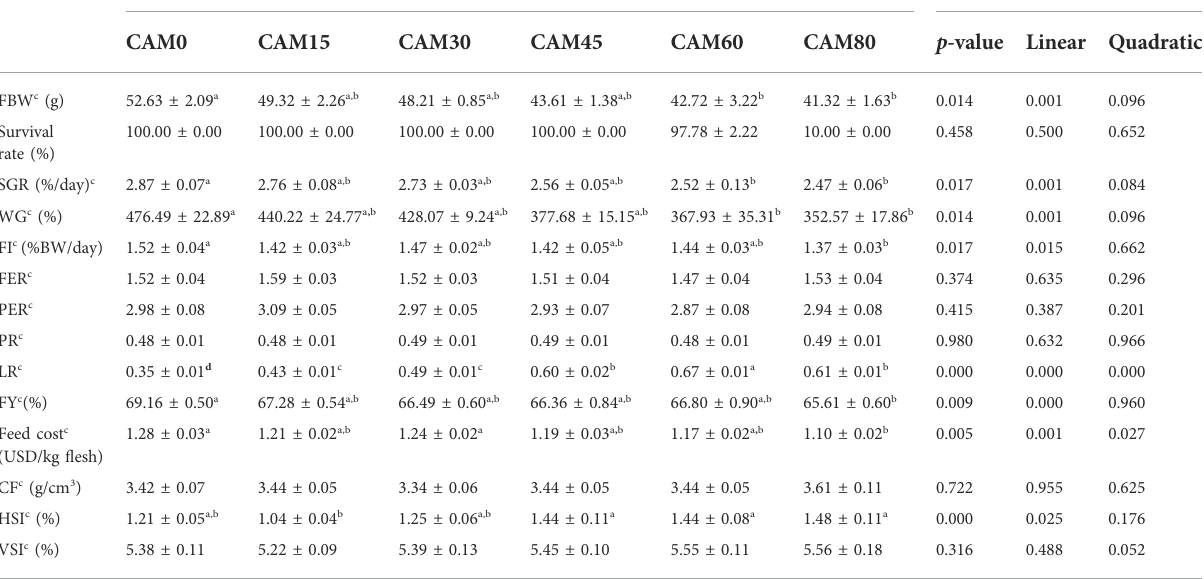
TABLE 6 Growth parameters, feed utilization and feed cost of juvenile turbot fed the experimental diets (Means ± S.E.M) a . Diets b Polynomial